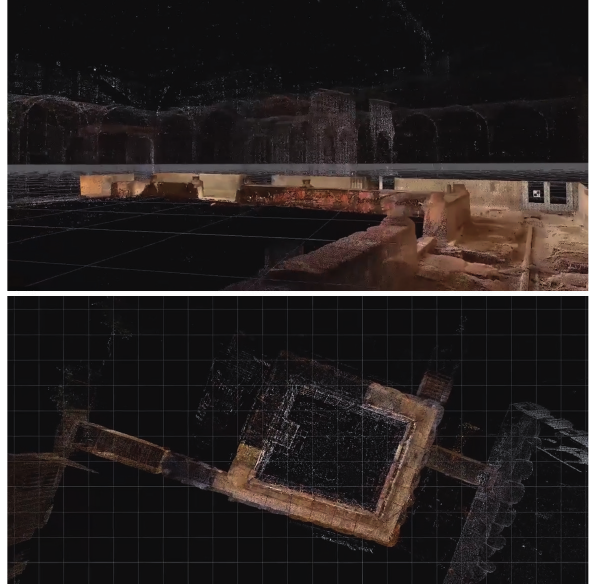
Figure 11. Phase 01 : the point clouds by 3D laser scanning and digital photogrammetry (the small cloister).